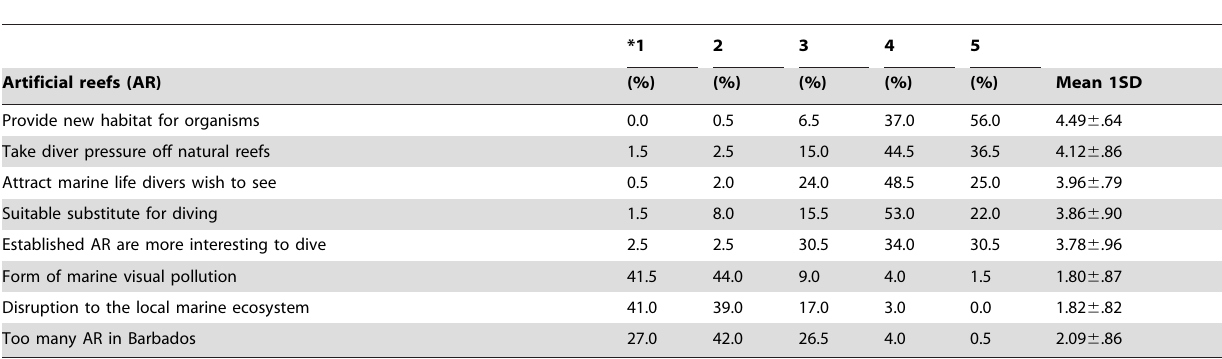
Table 3. Divers’ ranked percentage agreement/disagreement to attitude statements concerning artificial reefs, with positively worded statements positioned at the top of the table, and values for the negatively worded statements below.